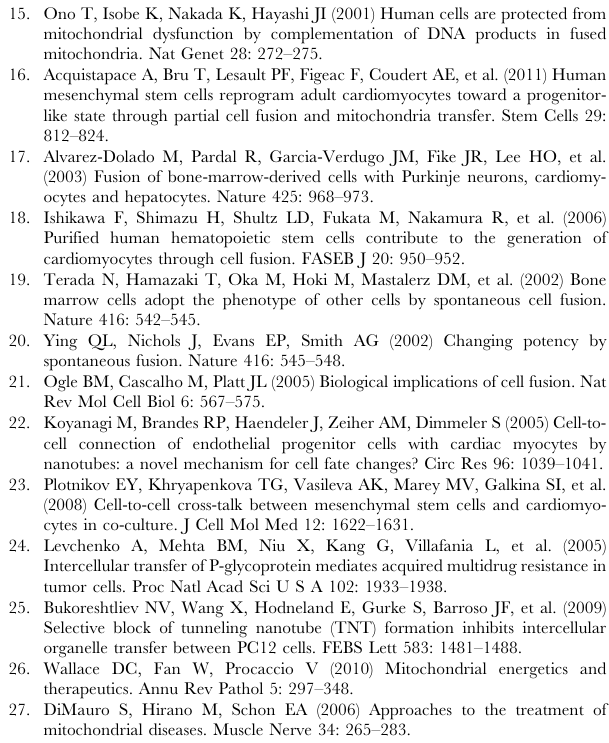
is missing, since no genes were allocated in this category. The line graph in each cell represents the average expression of all genes in the corresponding cluster with mean 6 standard error. Figure S3 BioLattice analysis. Concept lattice was con- structed from the 49 clusters shown in Figure S2 with significant GO annotations from the MSCs gene-expression dataset. Only 12 among the 49 clusters demonstrate at least one significant GO term(s) (P , 0.001) in the biological process category. Overall, the dataset shows 56 significant annotations with 56 unique GO terms. The core–periphery substructures are marked with colors (i.e., core in red, communicating in green, peripheral in gray and independent in yellow). The numbers in the lower semicircles is the cluster numbers shown in Figure S2. The numbers of the upper semicircles are the concept ID made by the current Biolattice analysis. Table S1 DNA fingerprinting analysis. Table S2 mtDNA D-loop sequence. (DOC) Table S3 GO annotations with P-value , 0.0001 in C1 of 4 6 4 clusters by SOM clustering. Table S4 GO annotations with P-value , 0.0001 in C4 of 4 6 4 clusters by SOM clustering. Table S5 GO annotations with P-value , 0.0001 in C6 of 4 6 4 clusters by SOM clustering.